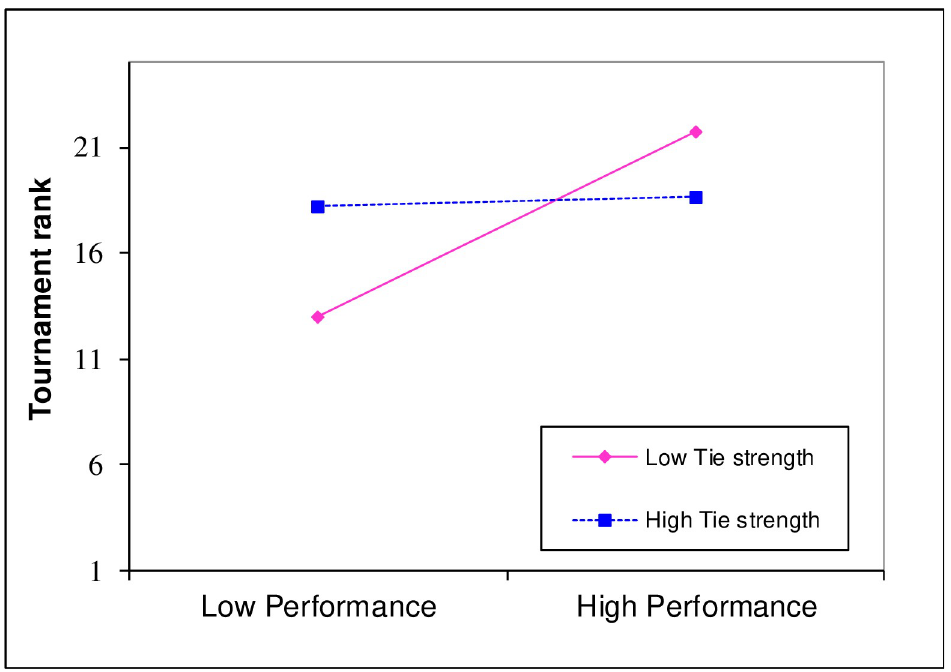
Fig 3. The interaction of performance and tie